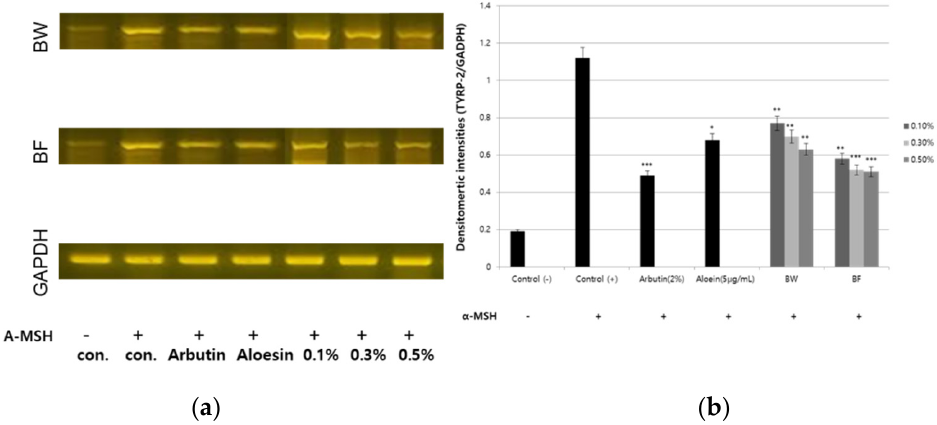
Figure 8. Downregulation of mRNA expression of TYRP-2 from α -MSH treated B16F10 cells ( a ) and relative densitometric intensities corresponding to each PCR band normalized with a house keeping gene, GAPDH ( b ) in treating various concentrations of two extracts of aloe skin leaf, and 5 µ g/mL aloesin and 2% arbutin as positive controls. BW: Water extract of aloe skin leaf at 100 ◦ C for 24 h. BF: Fermented extract of aloe skin leaf fermented with L. plantarum BN41 at 37 ◦ C for 3 days and further extracted by an ultrasound generator at 20 kHz for 4 h. The mean values ± SD for separate triplicate experiments are shown, and error bars indicate the SD. The significance of the difference was set to * p < 0.05, ** p < 0.01 and *** p < 0.001 compared with the control (+).